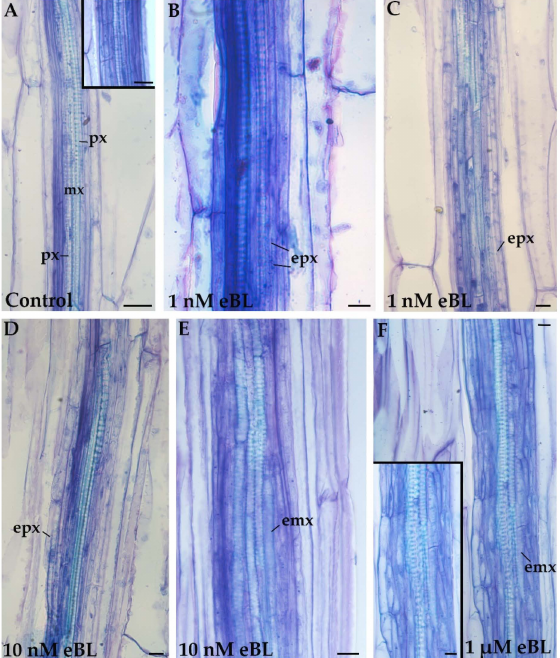
Figure 2. Xylogenesis in the basal hypocotyl of A. thaliana (Col ecotype) seedlings cultured for 9 days under continuous darkness followed by 7 days under 16 h light/8 h darkness photoperiod with different treatments. Reduced pericycle cell proliferation in the Control ( A and Inset ). Ectopic protoxylem (epx) elements formed in the presence of 1 nM of 24-epibrassinolide (eBL) ( B , C ). Ectopic protoxylem (epx) and ectopic metaxylem (emx) elements formed in the presence of 10 nM eBL ( D , E ). Ectopic metaxylem (emx) elements formed in the presence of 1 nM eBL ( F and Inset ). emx, ectopic metaxylem; epx, ectopic protoxylem; mx, metaxylem; px, protoxylem. Radial longitudinal sections stained with toluidine blue. Bars = 10 µ m.